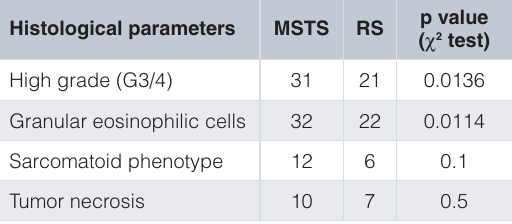
Table 1. Comparison between both sampling protocols showing that MSTS outperforms RS. Histological